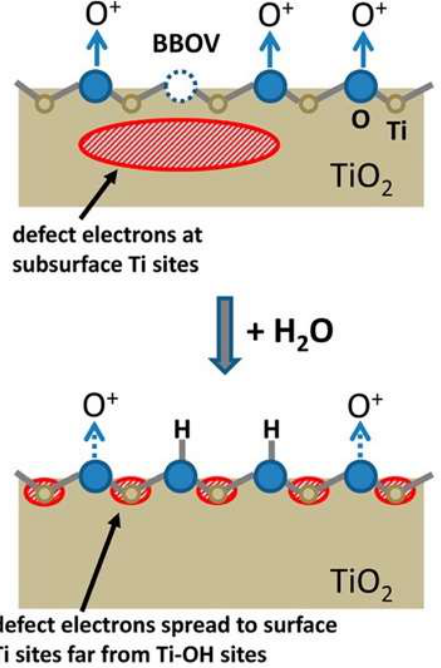
Figure 15. Influence of point defects in reduced Titania on their electronic structure. Reproduced from [144], Copyright 2013, American Chemical Society.